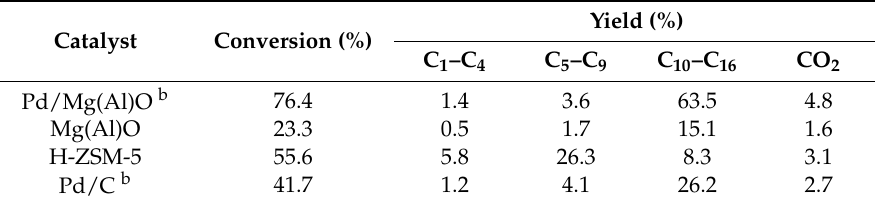
Table 1. The C 15 H 31 COOC 16 H 33 conversion and C 10 –C 16 hydrocarbons yield of the deoxygenation